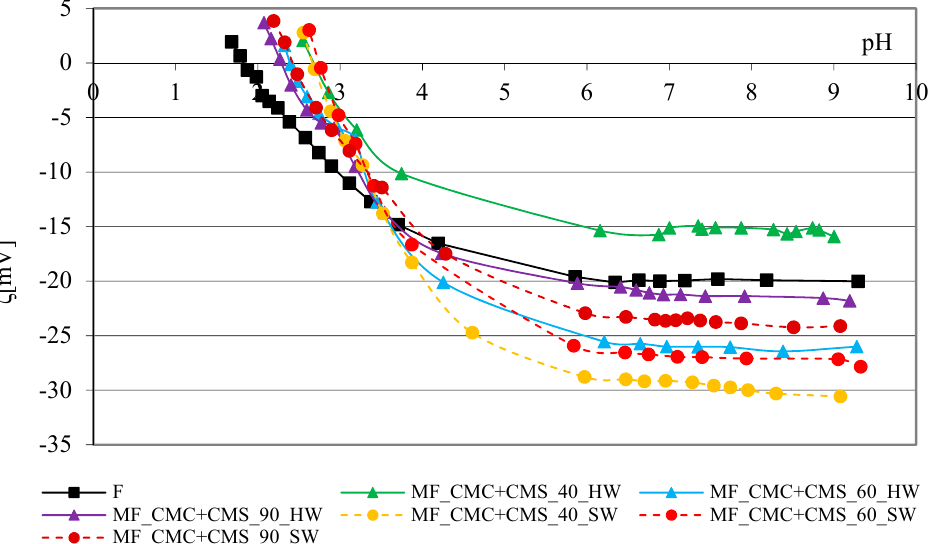
Figure 6. Zeta potential of cotton fabrics before and after 10 cycles of modification with detergent with CMC + CMS in hard and soft water at 40, 60 and 90 ◦ C depending on the pH of 1 mmol/L